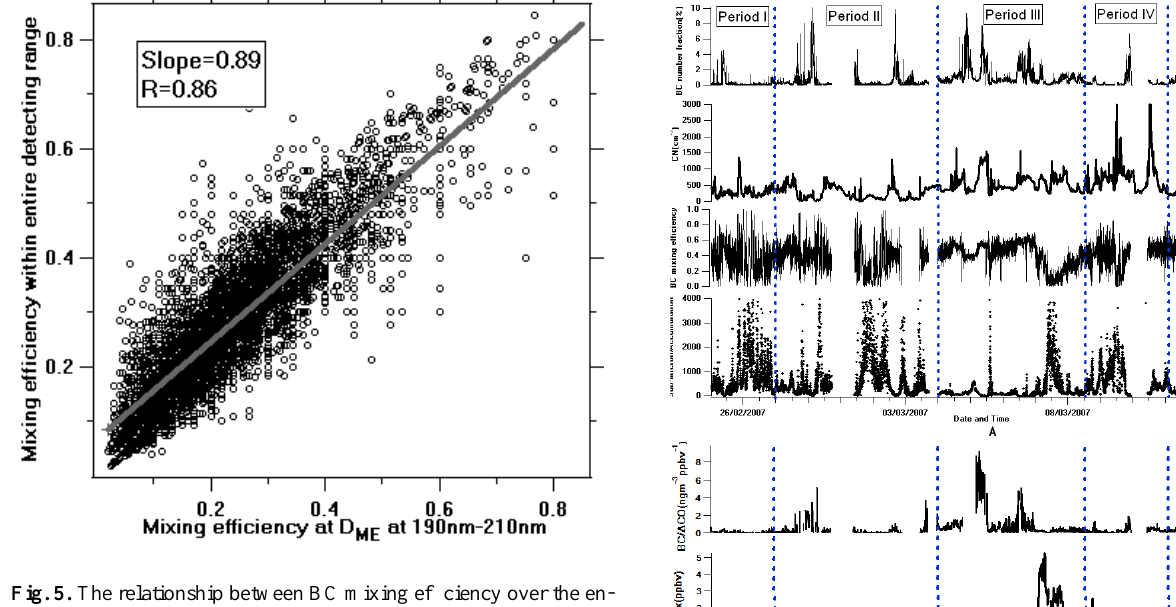
Fig. 5. The relationship between BC mixing efficiency over the en- tire size range of the SP2 and at the median diameter (190–210nm).